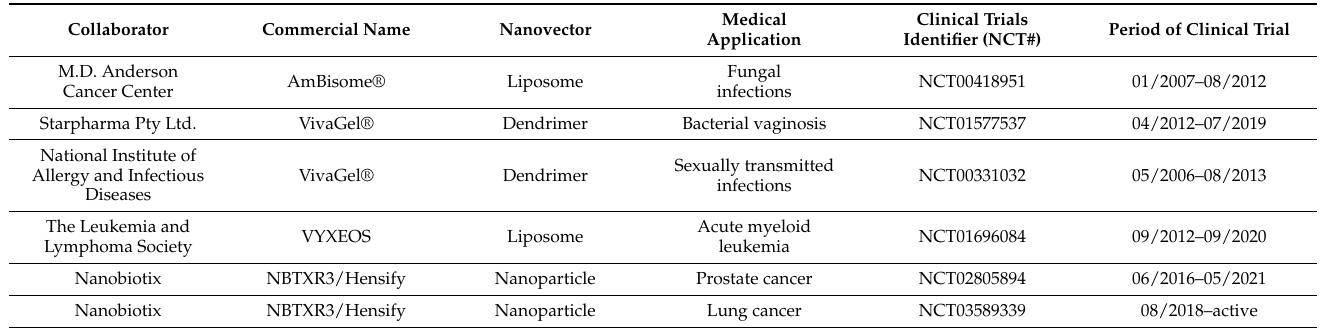
Table 3. Examples of commercial NVs evaluated in clinical